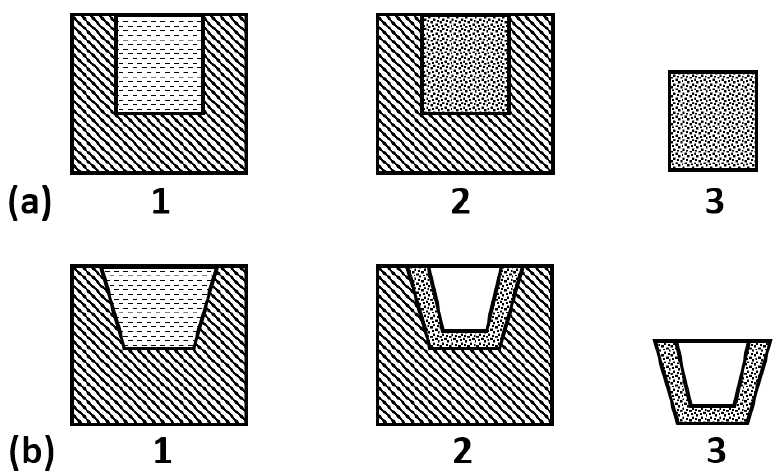
Figure 8. Schematics of с asting from aqueous slips: ( a ) manufacture of a cylinder-shaped green body with several slip re-pouring cycles; ( b ) crucible manufacture with removal of an excess